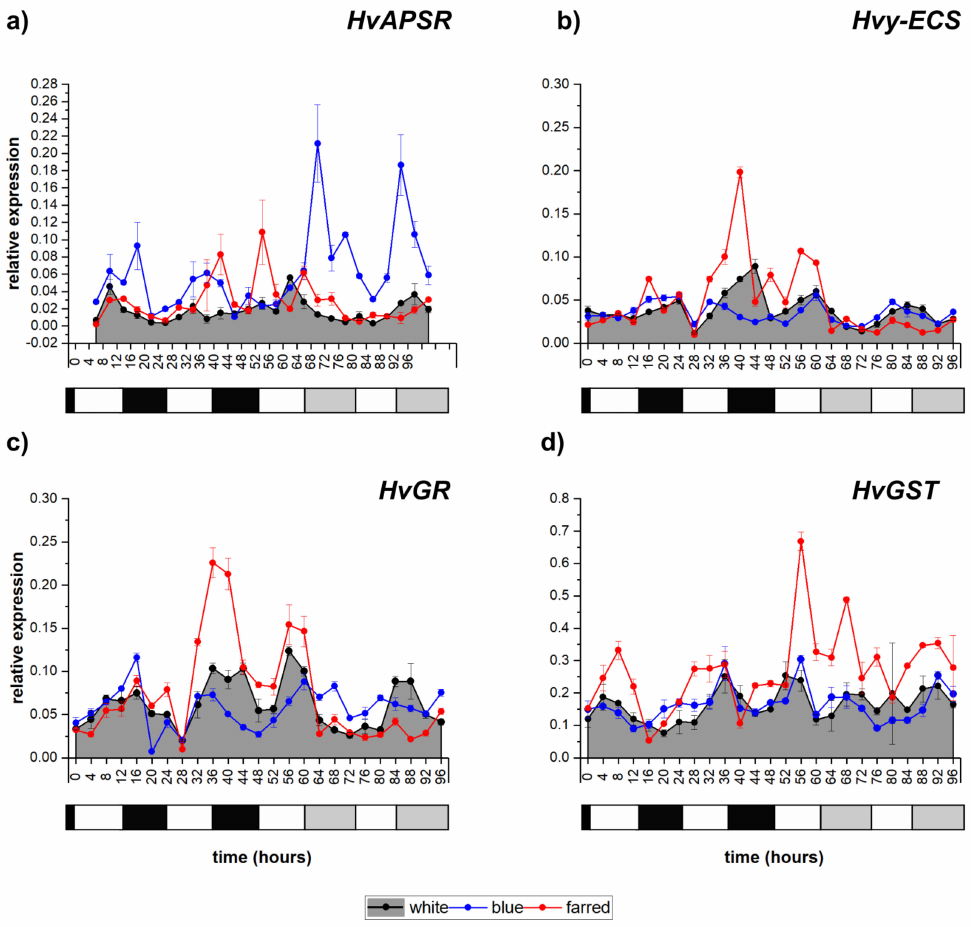
Figure 5. Expression patterns of H. vulgare genes related to glutathione metabolism: APS reductase ( HvAPSR) , ( a ) γ -glutamylcysteine synthetase1 ( Hv γ - ECS ), ( b ) glutathione reductase ( HvGR) ( c ) and glutathione S-transferase ( HvGST) ( d ), under white, blue and far-red light illumination, respectively. Calculating methods and the legends of graphs are the same as described in Figure 1. The following significant differences were calculated at p ≤ 5% level: HvAPSR— 0.019; Hv γ - ECS —0.023; HvGR— 0.016; HvGST